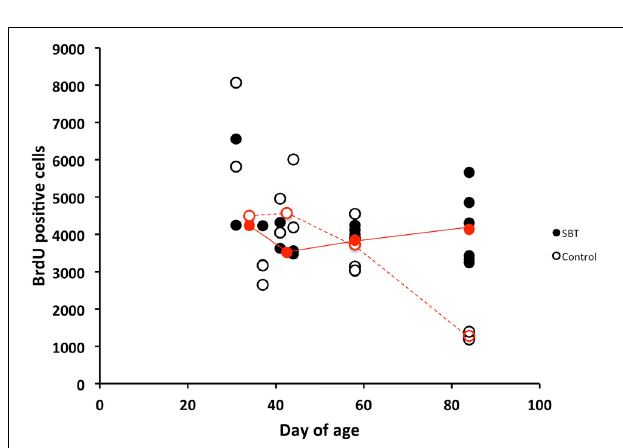
FIGURE 4 | Influence of SBT (250ppm) on cell proliferation in the SVZ of females of various ages. Male mouse pheromone stimulated cell proliferation in the SVZ of adult female mice but not in prepubertal-, or post-pubertal young female mice. Red circles indicate the medians at each age (filled red circles with solid lines indicate medians of females exposed to SBT and blank red circles with dashed lines indicate medians for control group females). Results of post-natal days 31 and 37 were used together to produce medians of post-natal day 31–37, and these of post-natal days 41 and 44 were used to produce medians of post-natal day